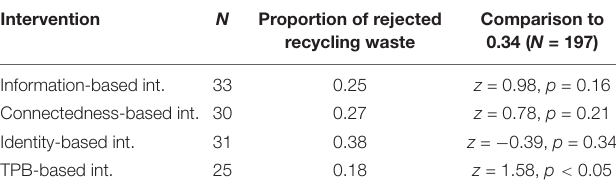
TABLE 6 | Proportion of sorting errors among the four conditions at T2. Intervention N Proportion of rejected Comparison to recycling waste 0.34 ( N = 197) Information-based int. 33 0.25 z = 0.98, p = 0.16 Connectedness-based int.